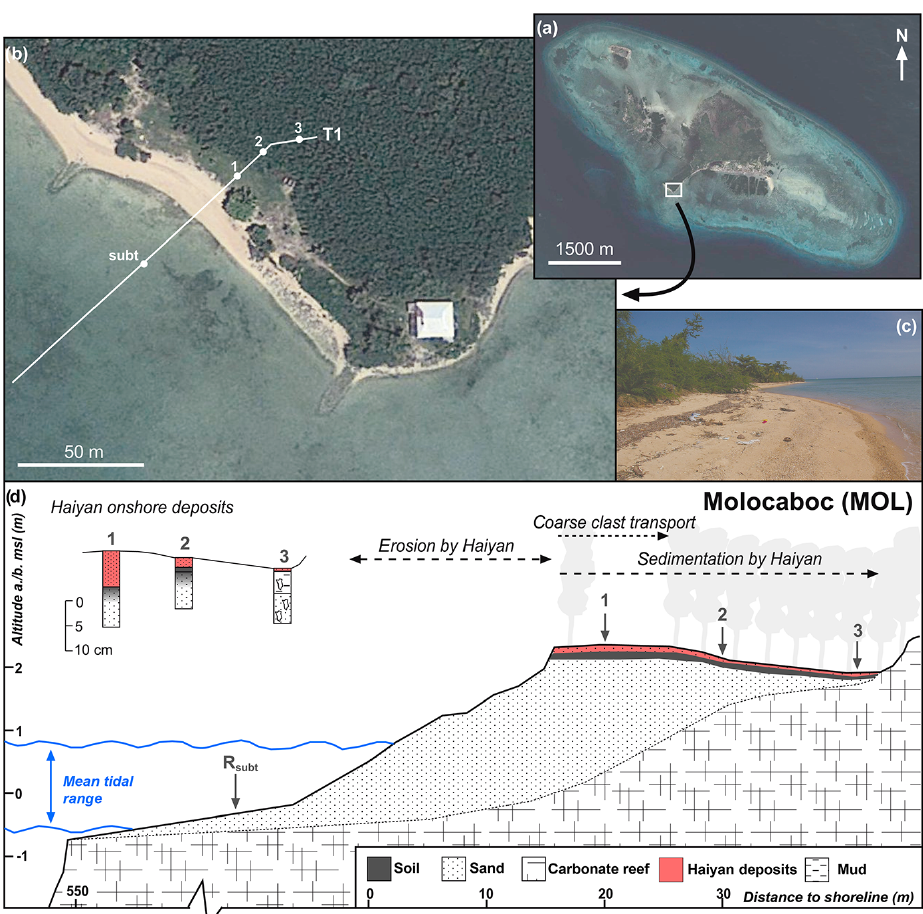
Figure 10. Molocaboc study site (MOL) with depositional and geomorphological effects of Typhoon Haiyan. (a) Location of studied beach section on Molocaboc. (b) Onshore sediments of Haiyan were investigated in three trenches (MOL 1–3) along a landward transect (T1). (c) Beach profile after the Haiyan impact (view towards SE; date: 20 February 2014). (d) Topographical cross section: the pre-Haiyan beach was substantially eroded and Haiyan generated a landward thinning sand sheet reaching up to 40m inland in the back-barrier